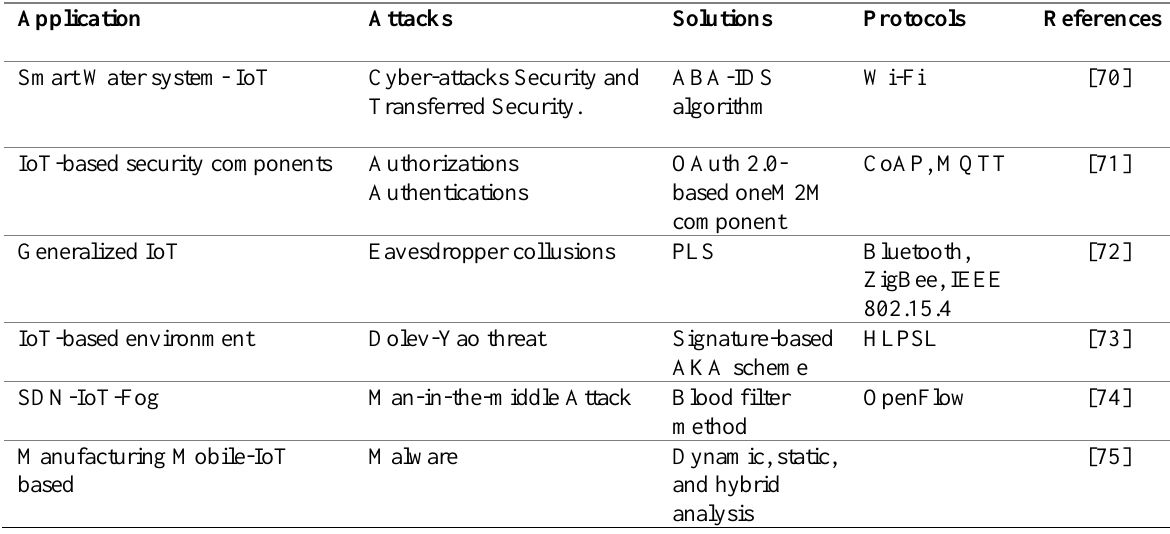
Table 1. Challenges and Strategies for IoT